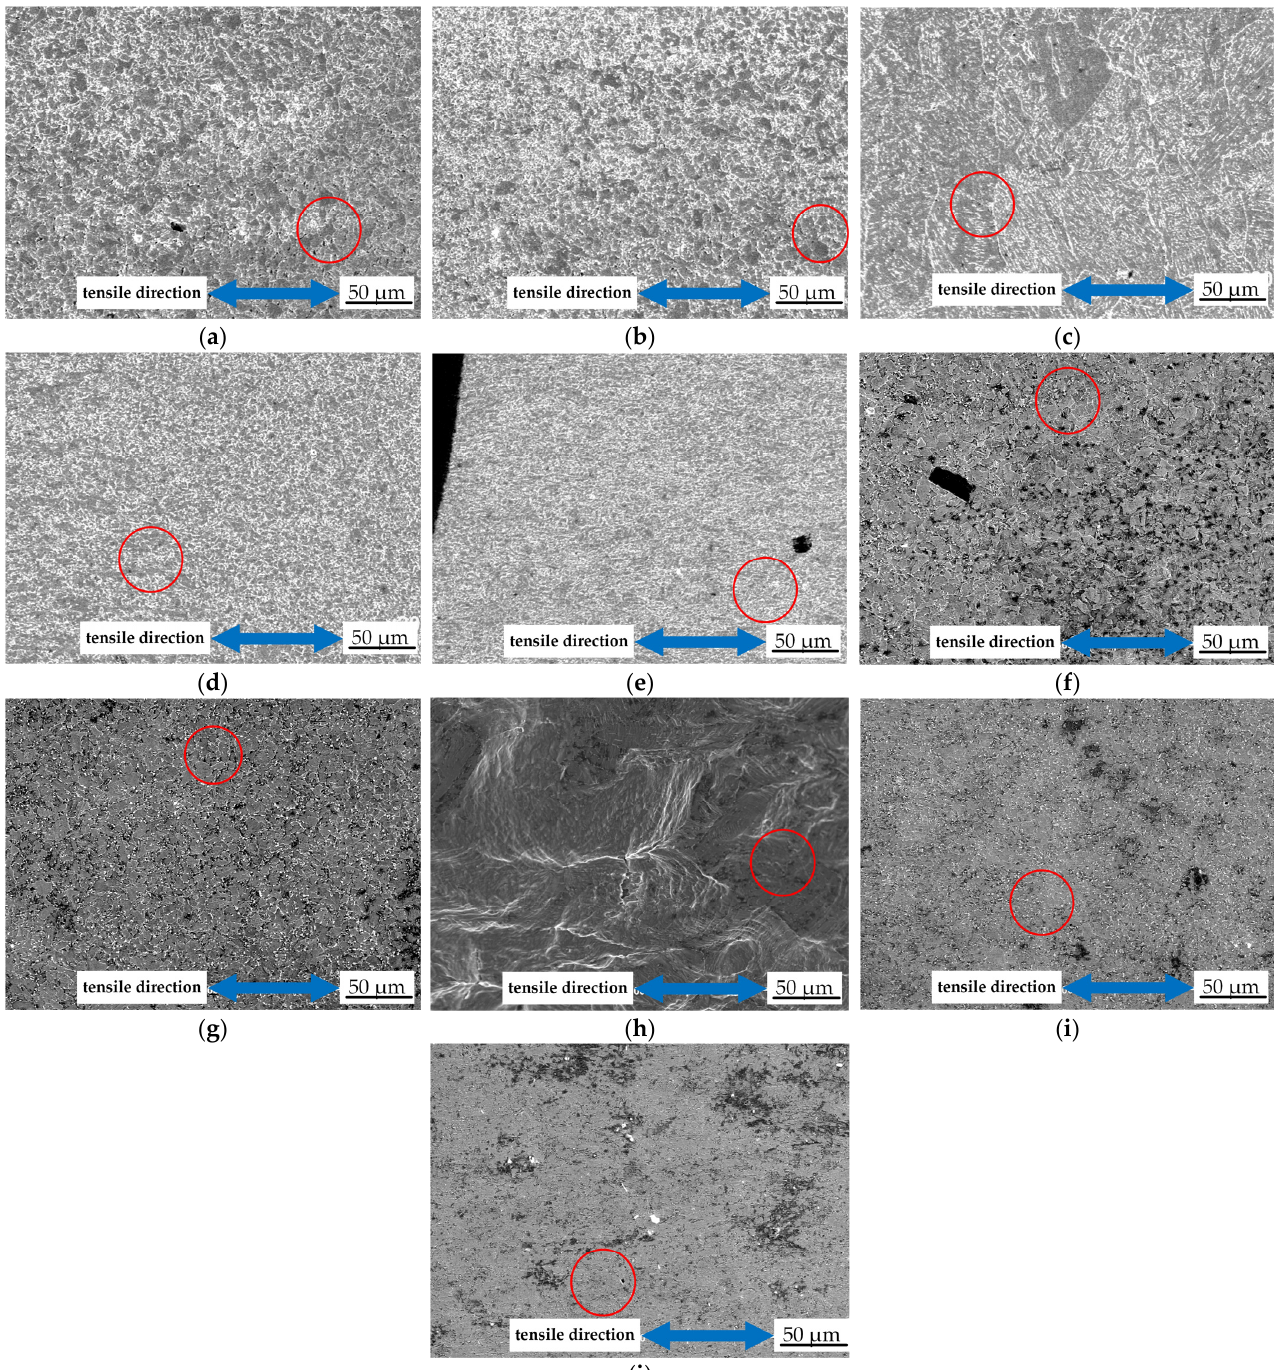
Figure 6. Microstructure and deformation characteristics in different zones: ( a ) original state at point A; ( b ) original state at point B; ( c ) original state at point C; ( d ) original state at point D; ( e ) original state at point E; ( f ) after No.2 at point A; ( g ) after No.2 at point B; ( h ) after No.2 at point C; ( i ) after No.2 at point D; ( j ) after No.2 at point E.